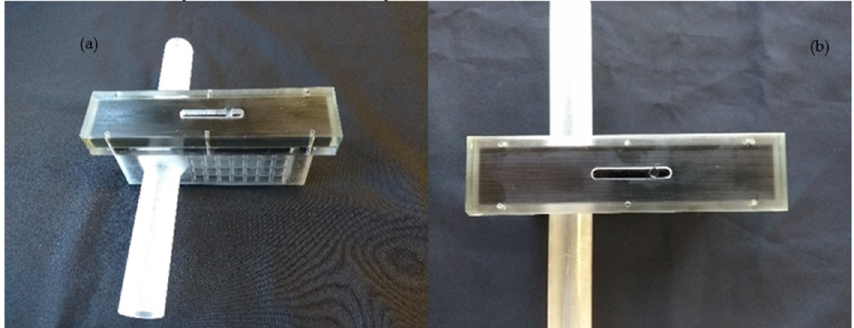
Figure 26. Valve prototype ( a ) general view; ( b ) front view.